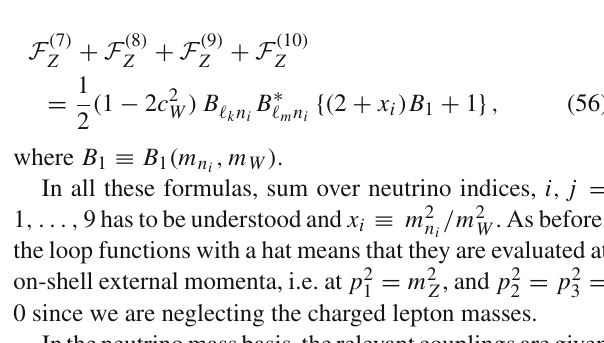
Fig. 8 One-loop diagrams in the Feynman–’t Hooft gauge contributing to the full computation of Z → (cid:3) k ¯ (cid:3) m decays in the physical neutrino mass eigenstate